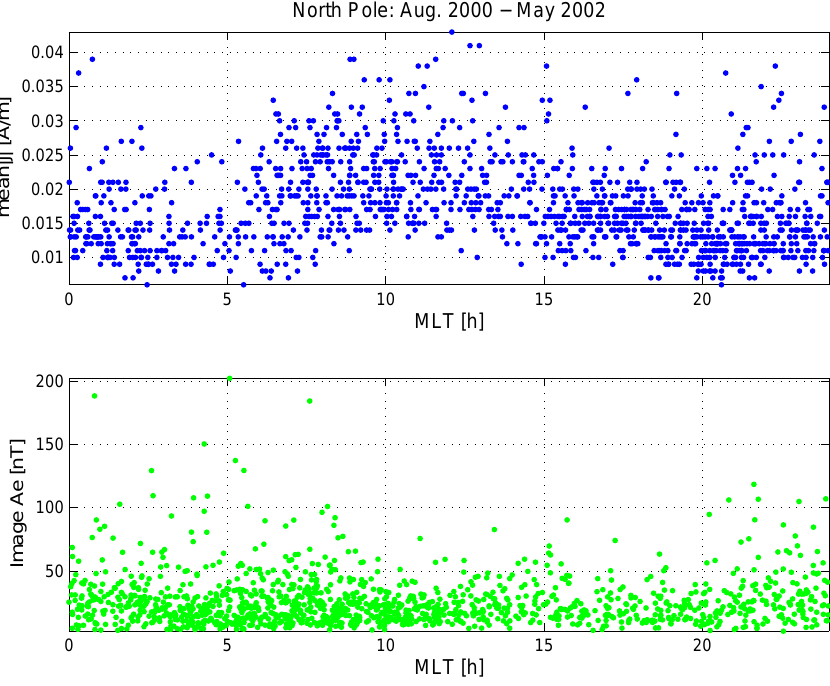
Fig. 4. Variation of the ionospheric Hall currents (IHCs) determined from the HAMP scalar residuals (top) and of the IMAGE- AE index (bottom) versus magnetic local time (at 70 ◦ cgm latitude) during very quiet orbits.